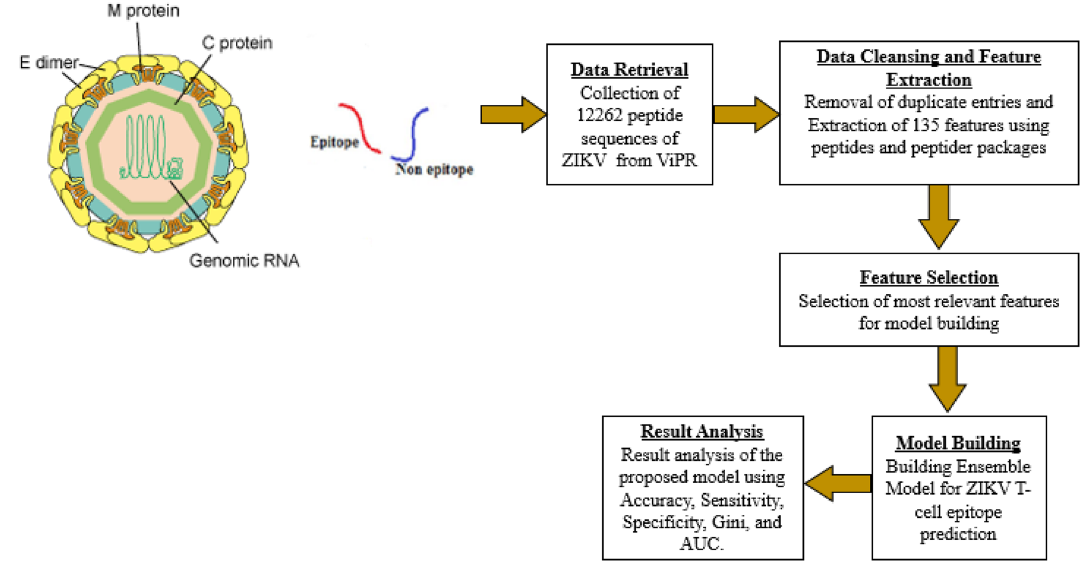
Figure 1. Proposed methodology.